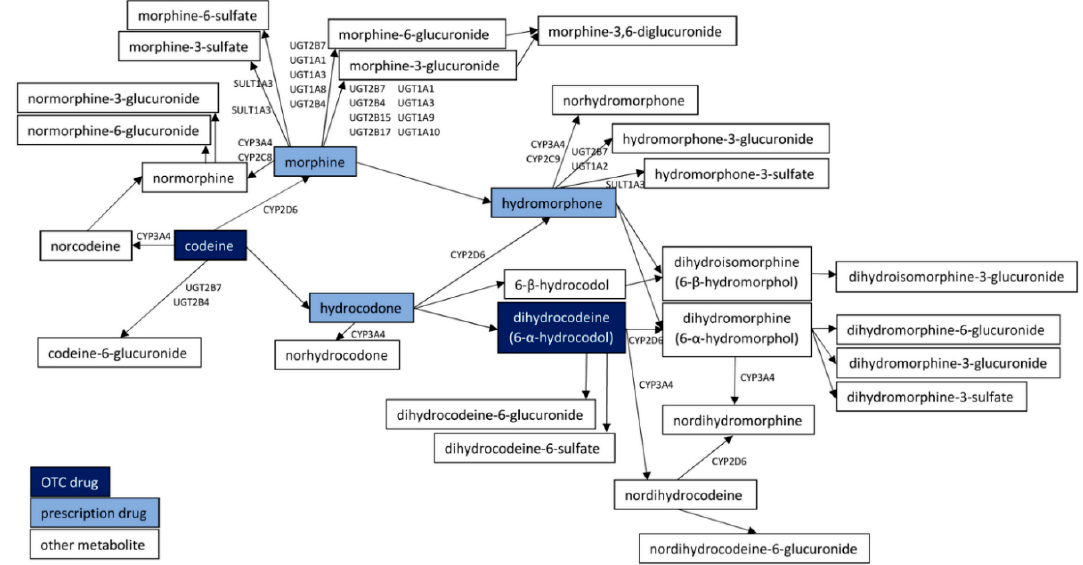
Figure 1. Metabolic pathways of codeine and dihydrocodeine. Abbreviations used: CYP = cytochrome P450, SULT = sulfotransferase, UGT = uridine diphosphate glucuronosyltransferase.